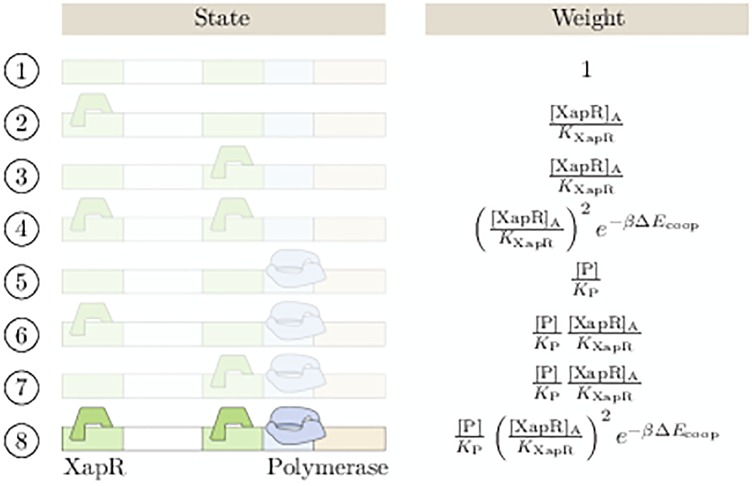
The promoter states.We consider only the completely occupied state as active and all other states (faded out in the figure) as completely inactive. The parameters are the interaction energy of the two XapR dimers ΔEcoop and the dissociation constants KXapR and KP of XapR and polymerase to the promoter, respectively. The concentrations of polymerase and active XapR are denoted by [P] and [XapR].